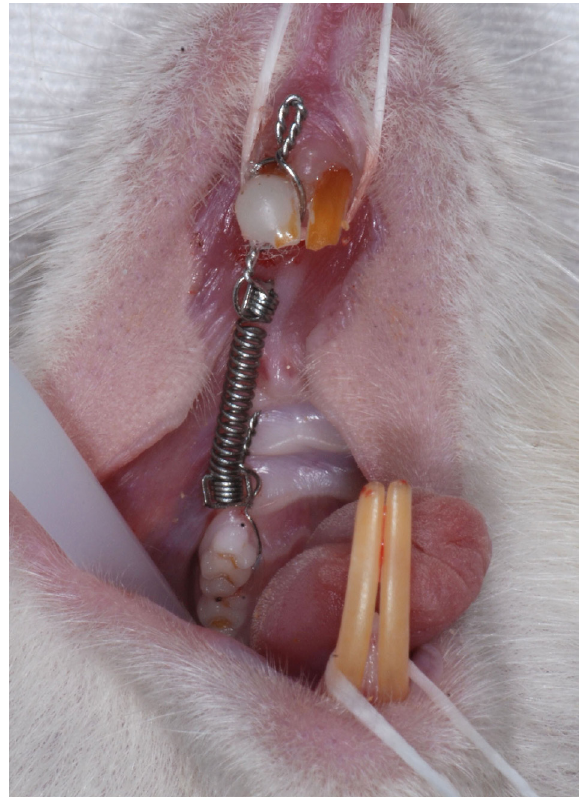
Figure 1- Intraoral photograph of nickel-titanium closed-coil spring between the right maxillary first molar and maxillary incisors of the